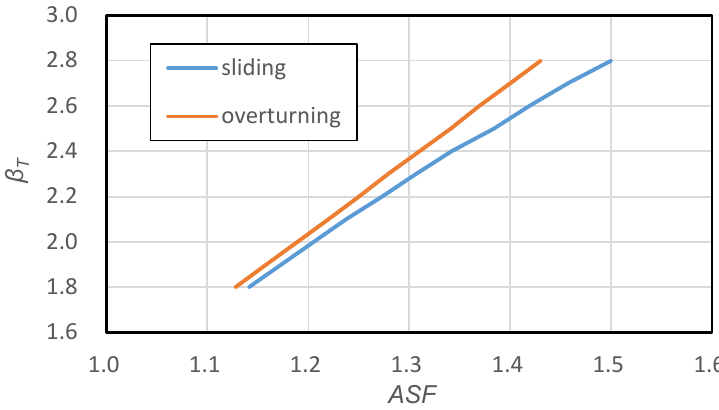
Figure 9. ASF vs. target reliability index.